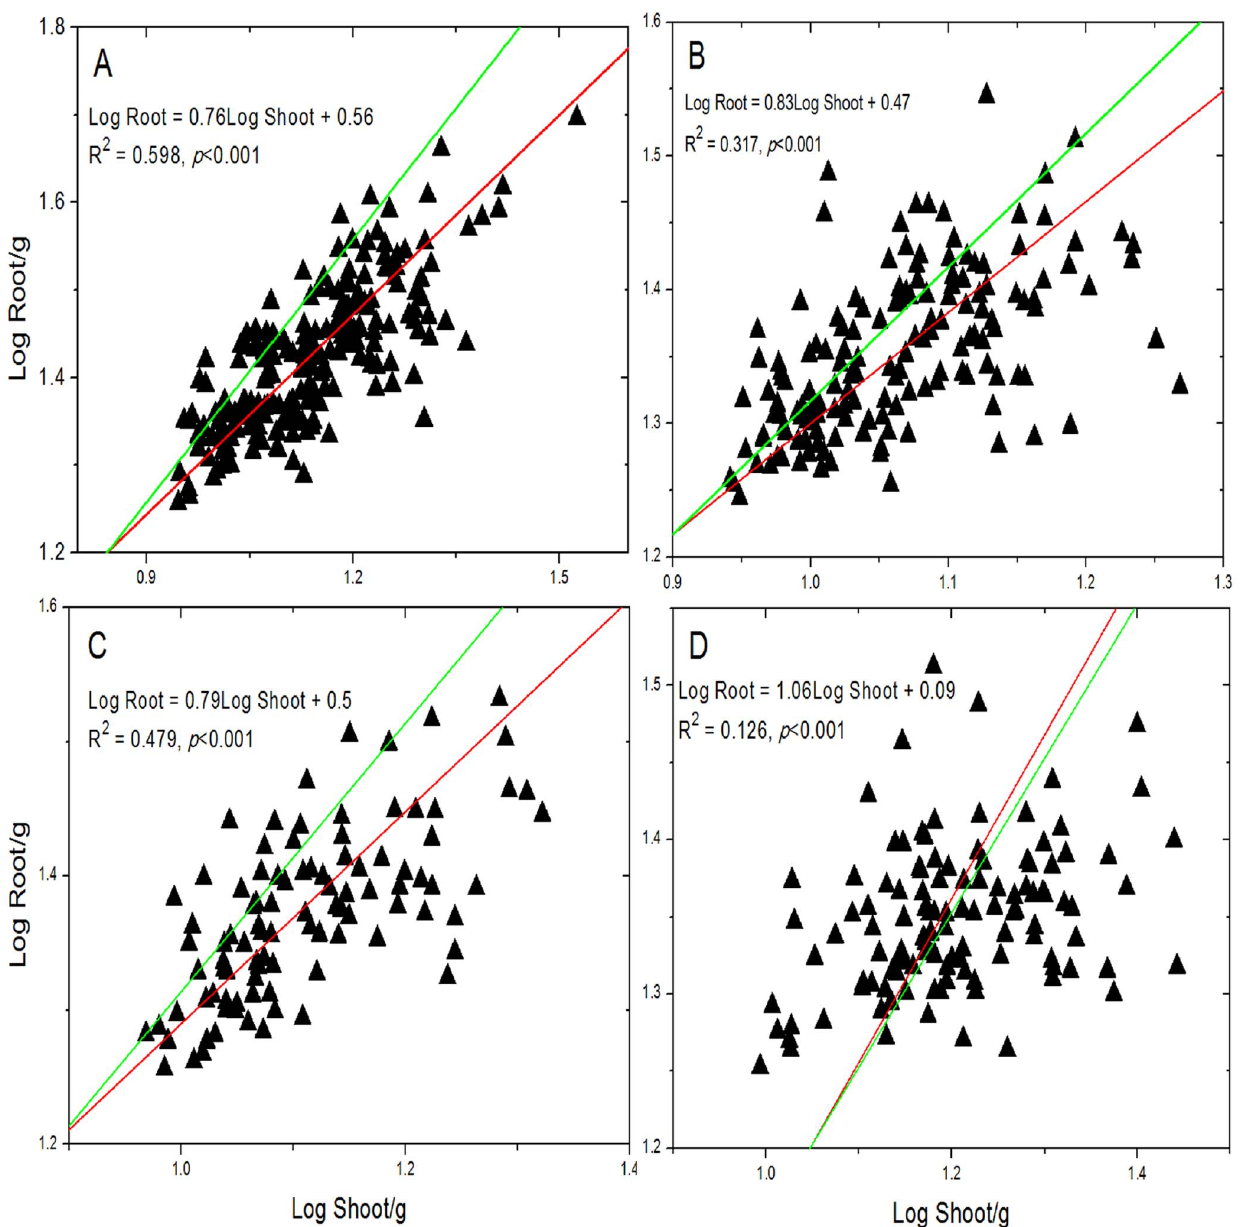
Figure 3. Allometric relationship between root biomass and shoot biomass. Stipa spp. (A), Cleistogenes spp. (B), Agropyron spp. (C), and Leymus spp. (D). Red lines are the standardized major axis regression curves (for a summary of regression statistics, see Table 5). Green lines are isometric lines with slope equal to 1 and y-intercept equal to that of the corresponding red lines.